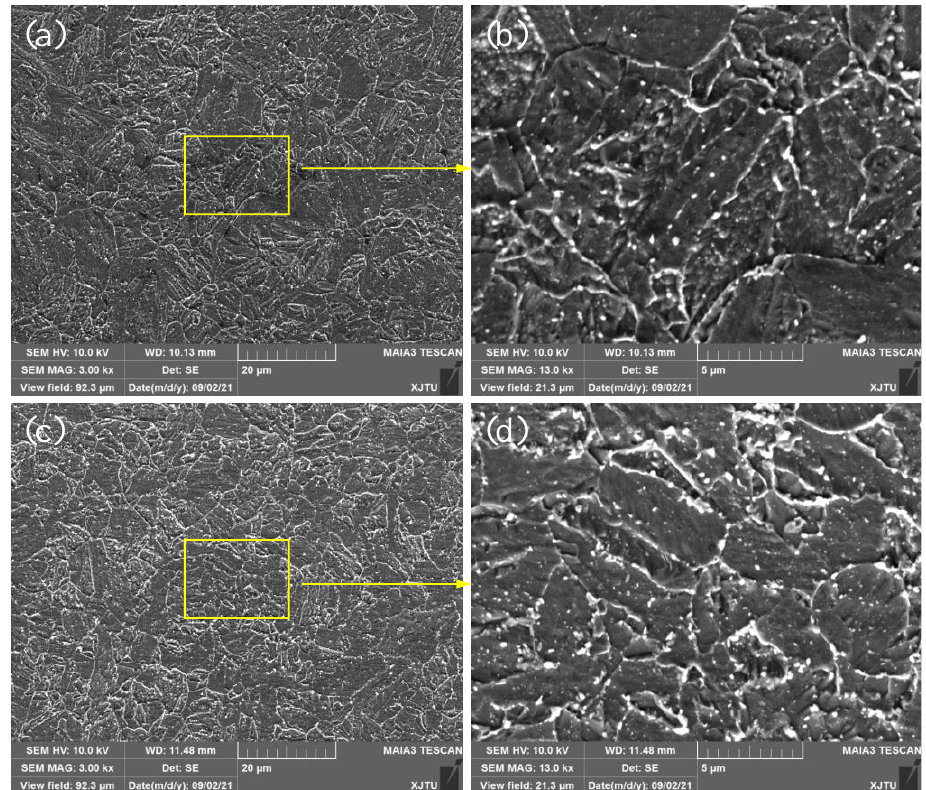
Figure 2. Microstructures of 2.25Cr1Mo0.25V steel ( a , b ) BM and ( c , d ) WM. The magnified SEM images ( c , d ) show the presence of a number of fine carbides in the grain boundaries and ferrite matrix.